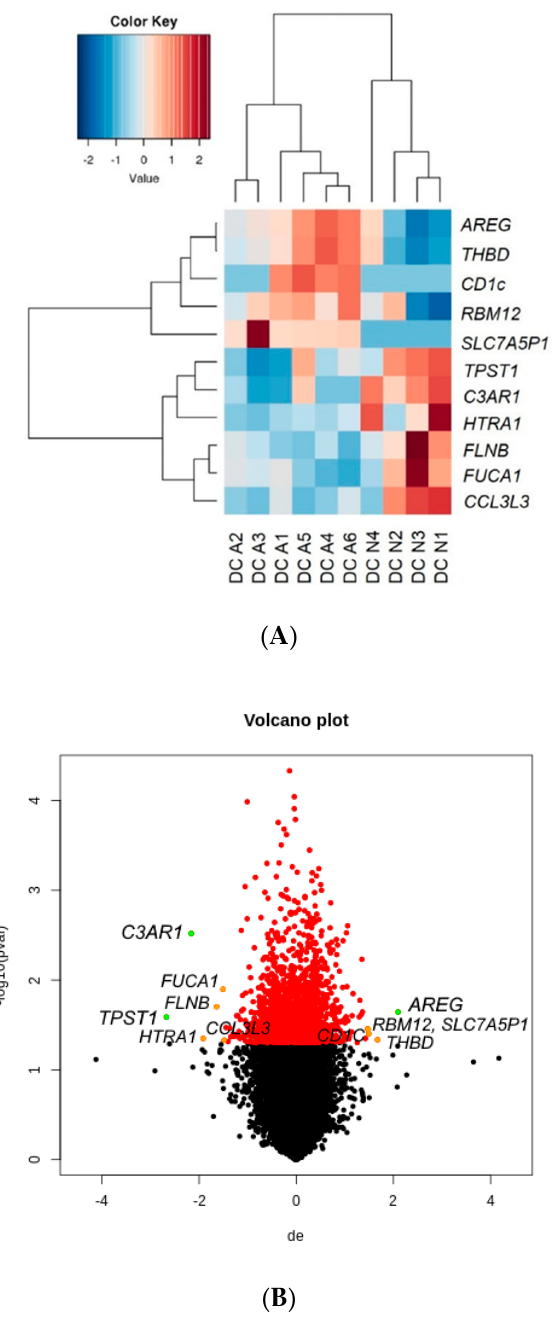
Figure 1. Differentially expressed genes (DEGs) identified in dendritic cells (DCs) from patients with allergies versus controls: ( A ) Heat map constructed with five upregulated genes and six downregulated genes with P -values < 0.05 and |Log2FC| ≥ 1.5. Color key indicates the degree of differential gene expression in either direction (red color represents upregulation; green color represents downregulation); ( B ) Volcano plot was constructed by plotting the log2FC of individual genes on x -axis and the negative logarithm of their P -value to base 10 on y -axis. Colored circles refer to 1658 DEGs with P -values < 0.05, and among those, orange circles represent genes with |Log2FC| ≥ 1.5, while green circles refer to genes with |Log2FC| ≥ 2.0.